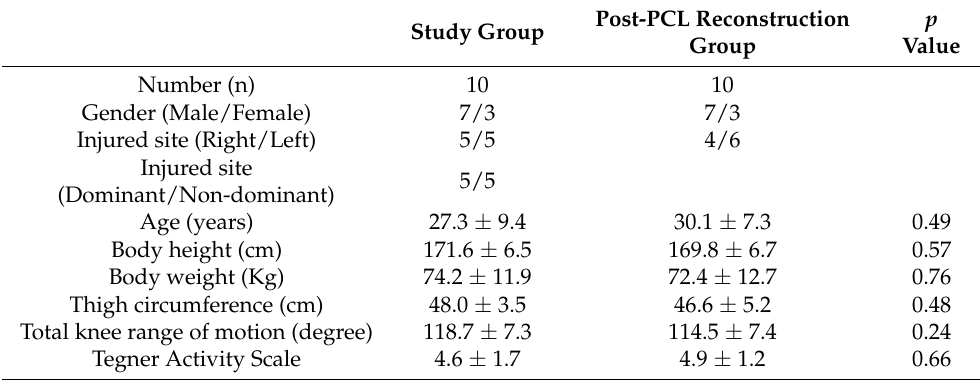
Table 1. Patient profiles in the study (training) and post-PCL reconstruction